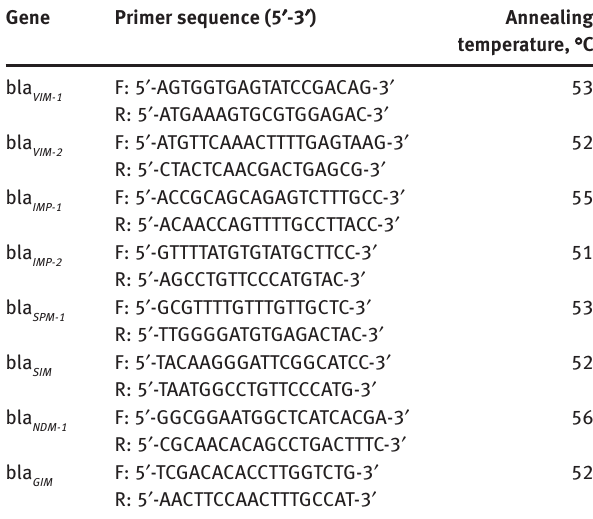
Table 1: Gene-specific primer sequence. Gene Primer sequence (5 ′ -3 ′ )